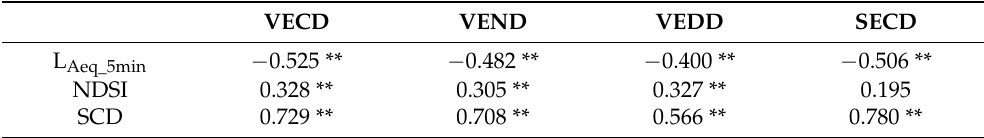
Table 9. Spearman’s rho correlation coefficients for the relationships between subjective evaluations of visual and smell environments and soundscape evaluation parameters.